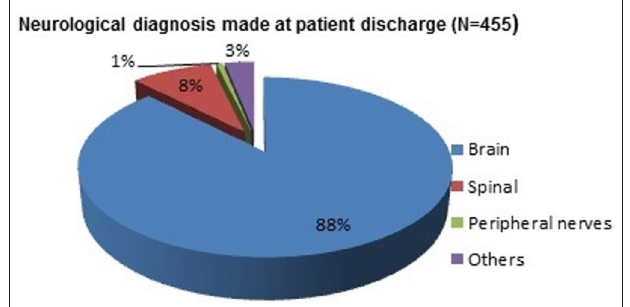
FIGURE 1 | Neurosurgical diagnosis at